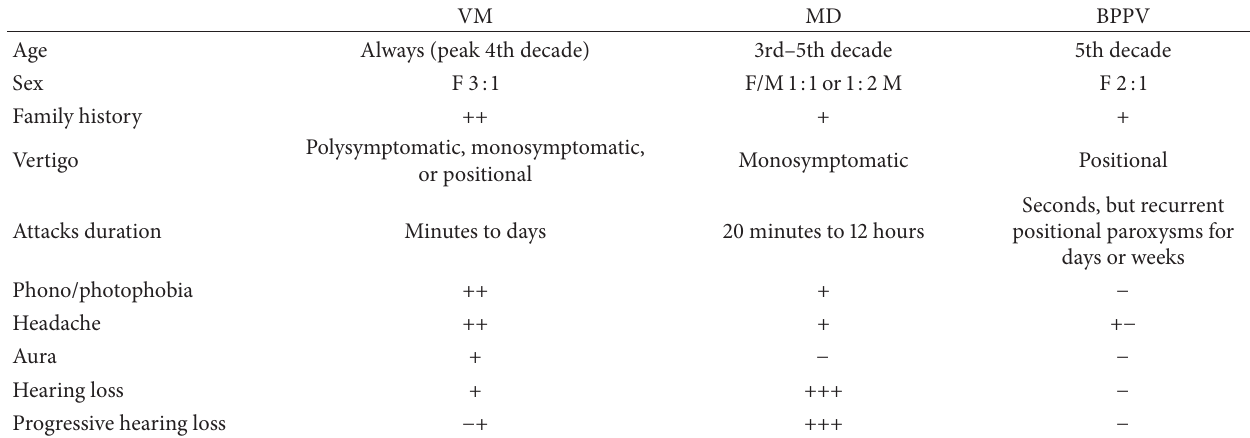
Table 1: Vestibular migraine, MD, and BPPV: distinctive